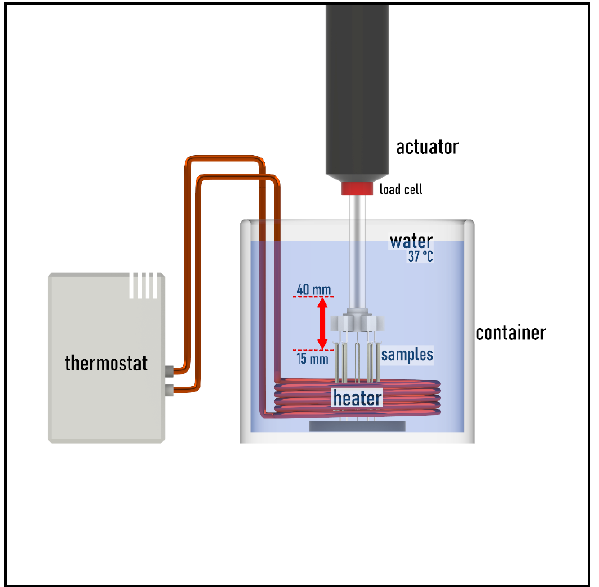
Figure 2. The temperature chamber and the measuring system.